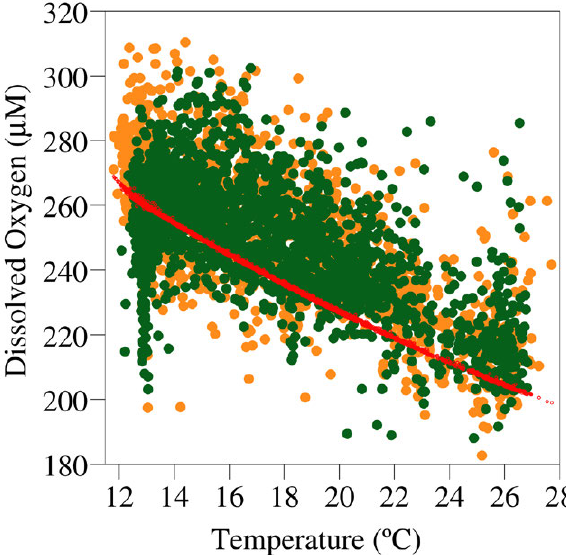
5. – Surface water (0-50 m) dissolved oxygen concentration (green dots: open sea, orange dots: continental shelf), and dissolved oxygen saturation (red, calculated from in situ S and T) as a function of